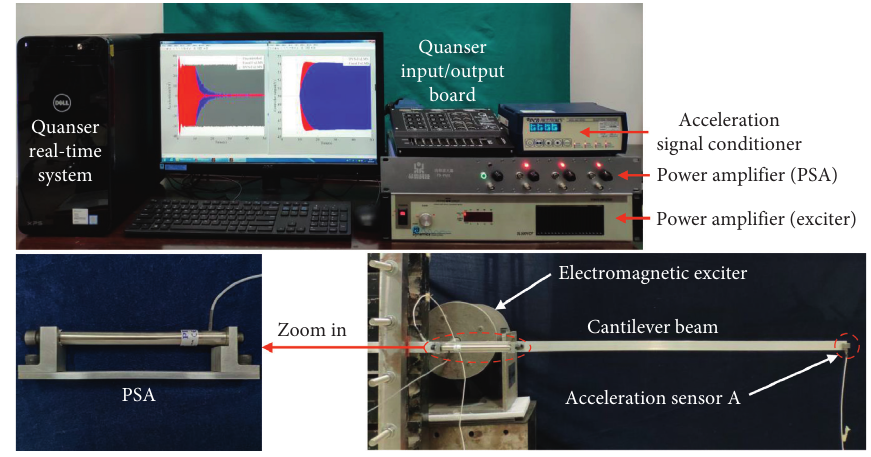
Figure 9: The setup of AVC experiment using